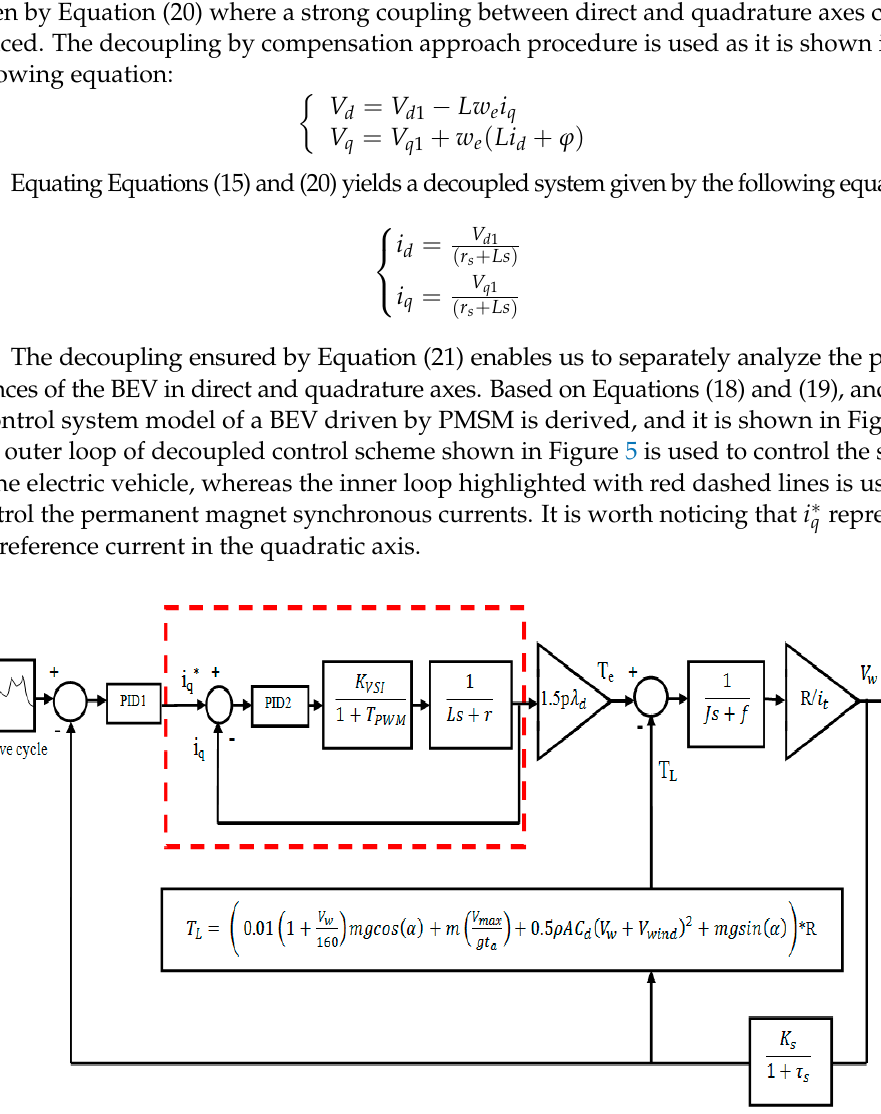
Figure 5. Decoupled control scheme of the electric vehicle driven by PMSM.